Question: Name the type of graph shown.
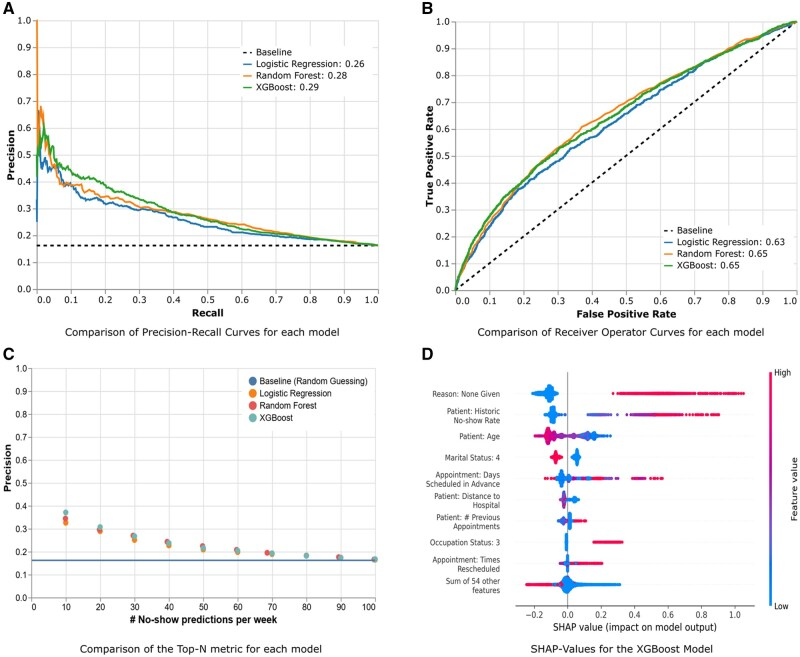
Answer: line